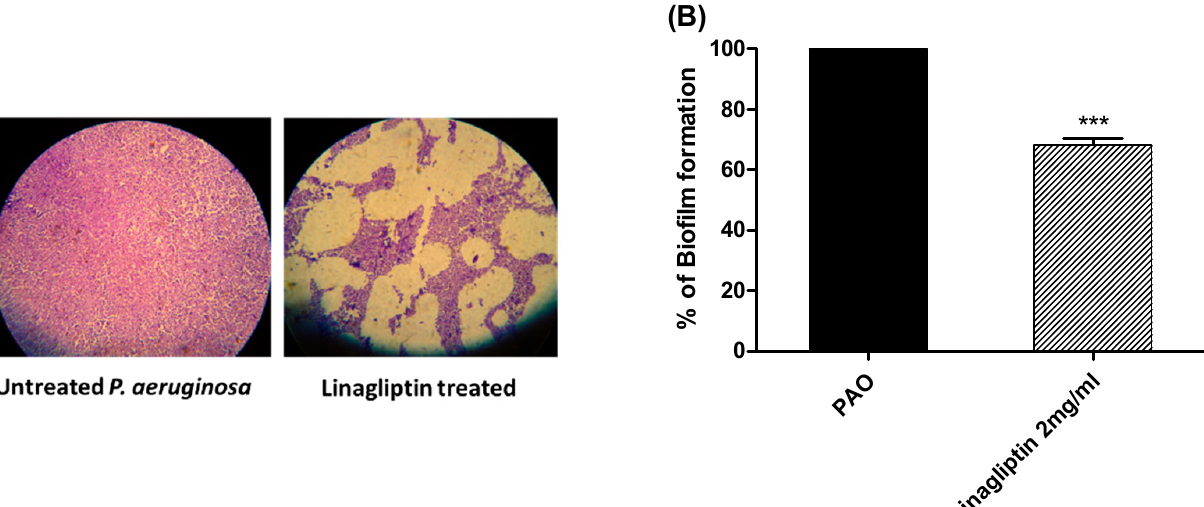
Figure 2. Linagliptin inhibits biofilm formation. The crystal violet method was used to evaluate the anti-biofilm activity of linagliptin at sub-MIC. ( A ) Light microscope images represent the biofilm formation in the presence and absence of linagliptin. Linagliptin markedly decreased the biofilm formation. ( B ) The absorbances of stained biofilm-forming cells were measured in the presence and the absence of linagliptin at sub-MIC. Linagliptin significantly diminished the biofilm formation, *** = p ≤ 0.0001.